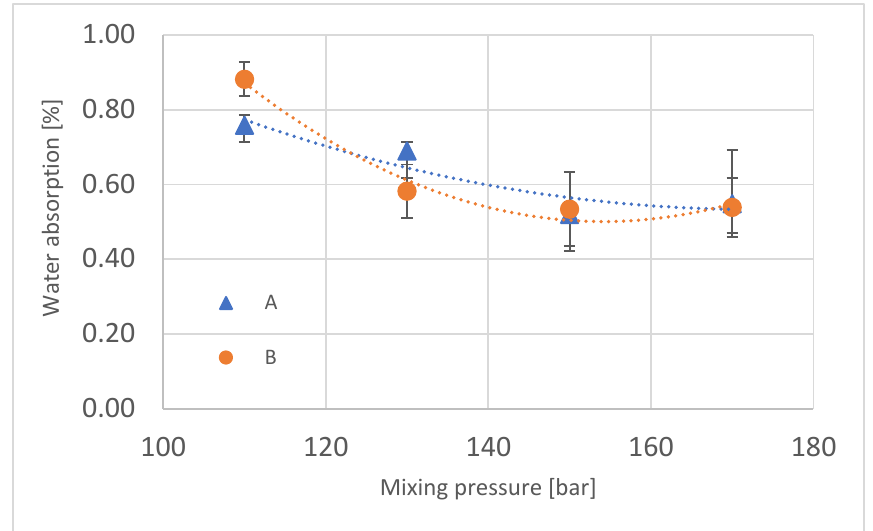
Figure 11. Water absorption of manufactured polyurethane blocks.